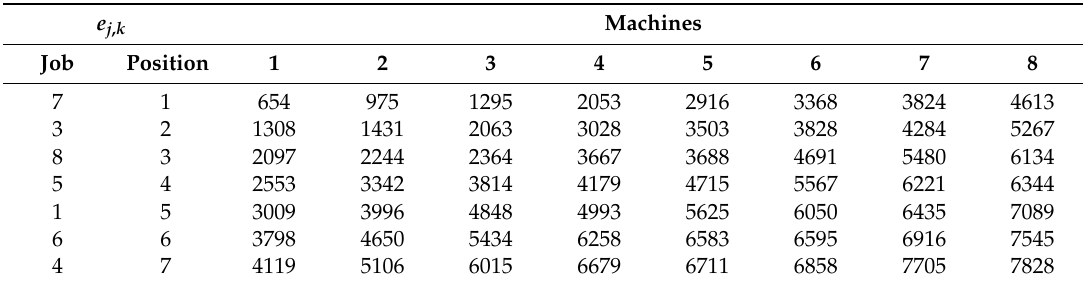
Table A2. Completion times of partial permutation.